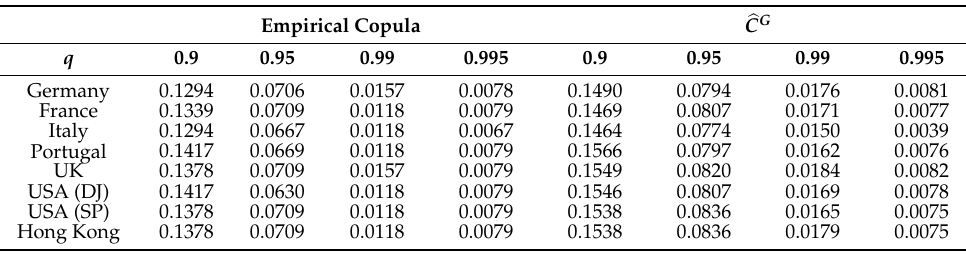
Table A3. Values of 1 − C ( q , q ) for Spain and th countriese analysed, estimated with the empirical copula and Gaussian transformed kernel